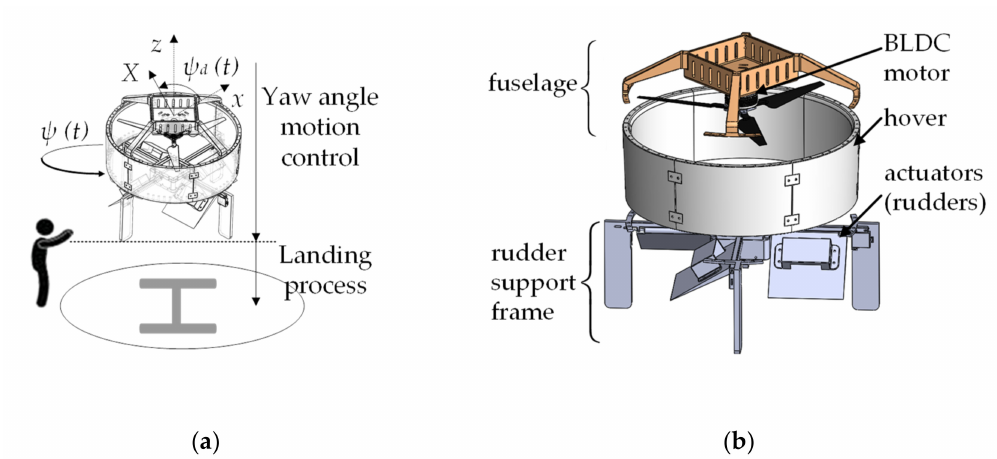
Figure 2. The yaw angle motion control of the designed DUAV model: ( a ) The yaw angle control process before the landing; ( b ) The structure of the DUAV